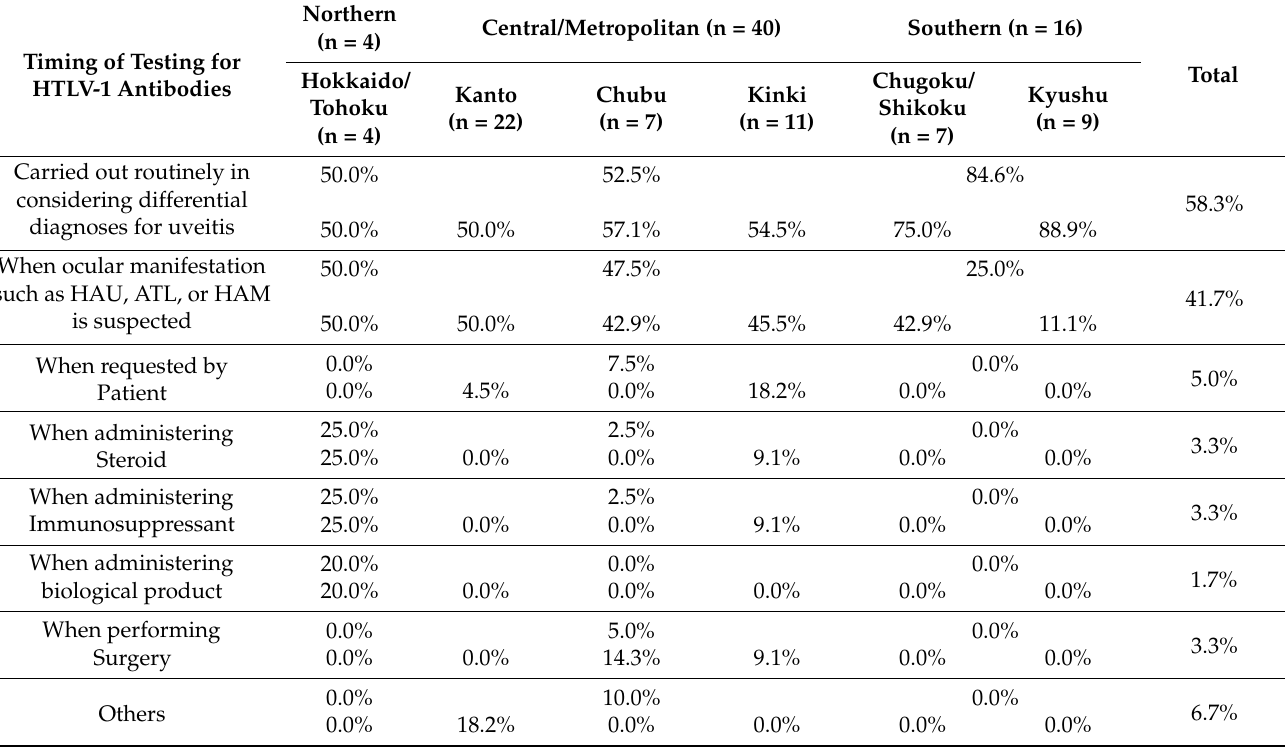
Table 1. Timing of testing for HTLV-1 antibodies.